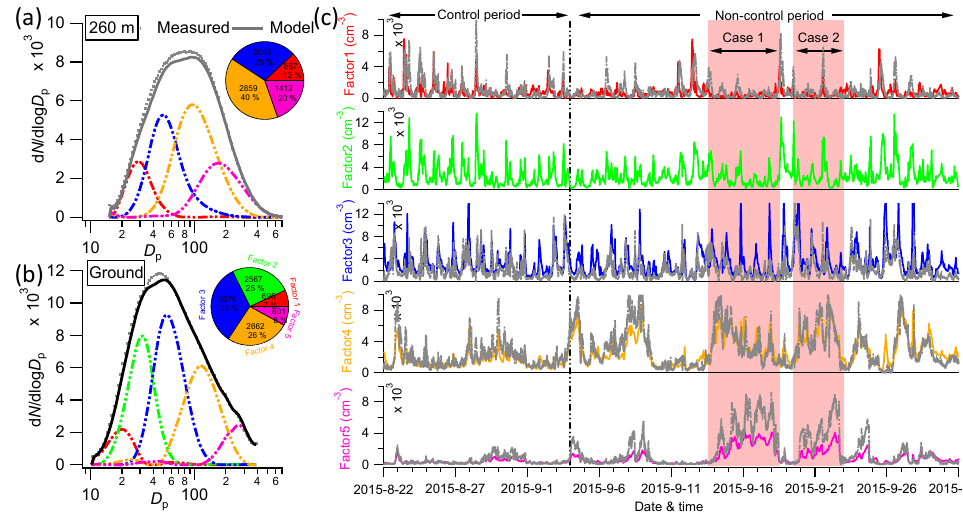
Figure 9. Panels (a) and (b) show factor profiles of particle number size distributions at 260m and ground level, respectively. (c) Comparisons of the time series of PMF factors at 260m (dashed gray lines) and ground level (color-coded